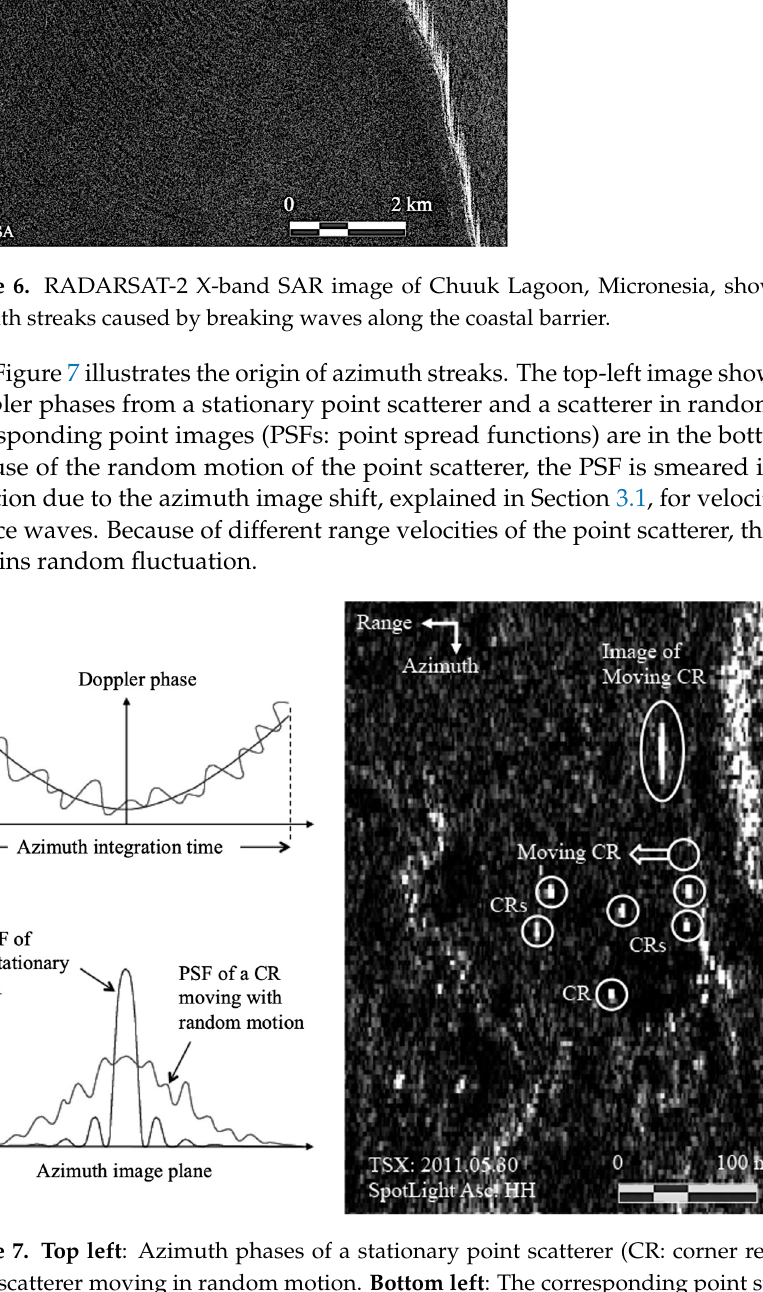
Figure 7. Top left : Azimuth phases of a stationary point scatterer (CR: corner reflector) and the point scatterer moving in random motion. Bottom left : The corresponding point spread functions (PSF) of the stationary and moving CRs. Right : TerraSAR-X image showing stationary and moving corner